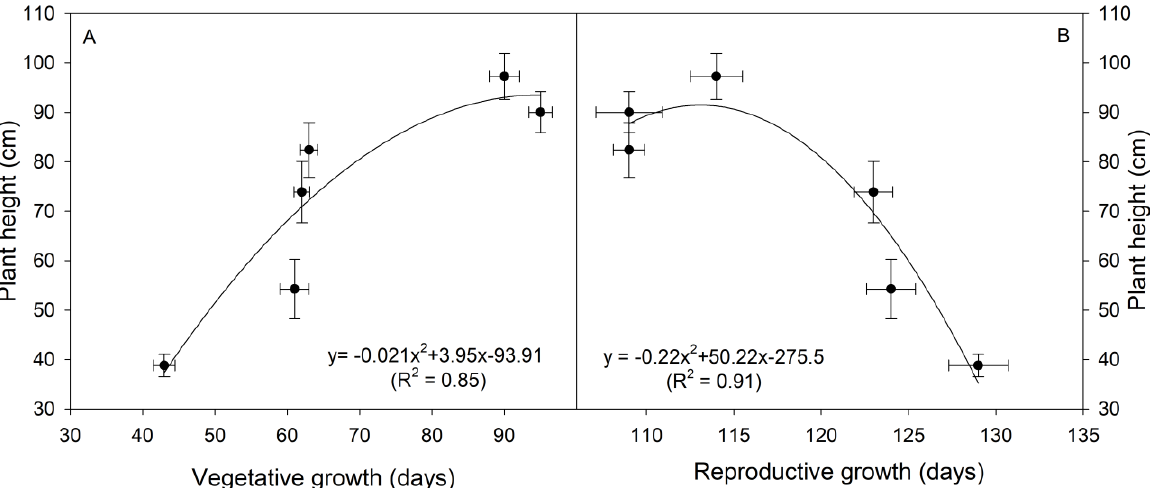
Figure 5. Relationships between plant height and the vegetative growth ( A ), and plant height and the reproductive growth ( B ) of six white lupin ( Lupinus albus L.) genotypes.